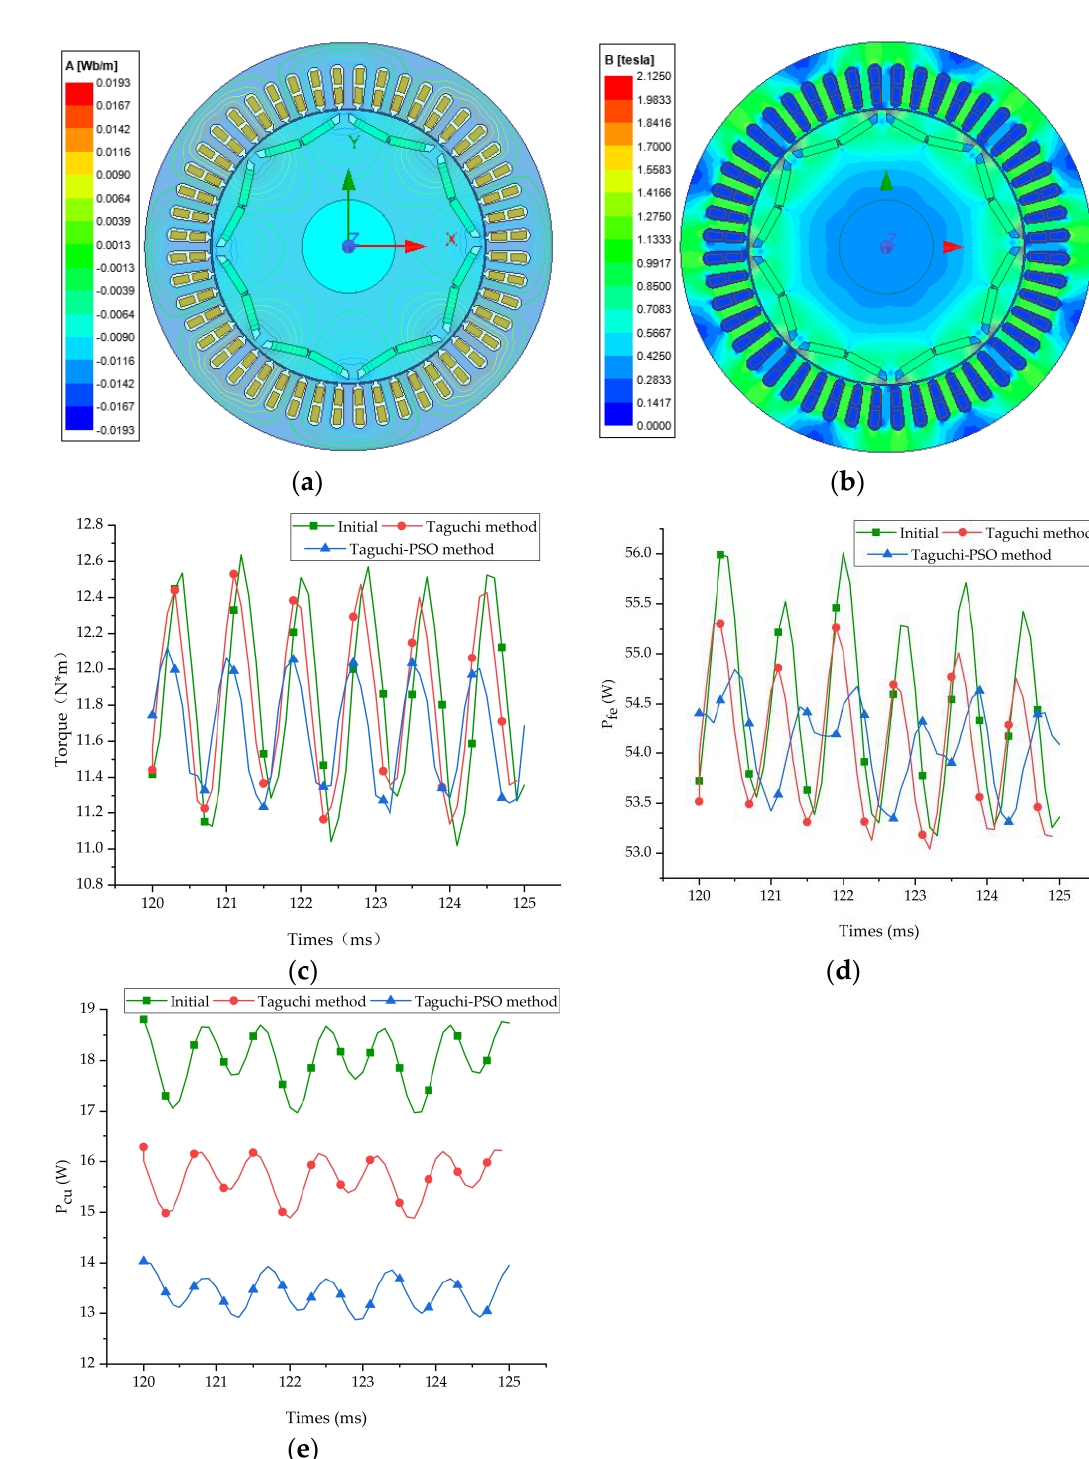
Figure 5. Performance comparison of the initial motor and the optimized motor: ( a ) magnetic flux of